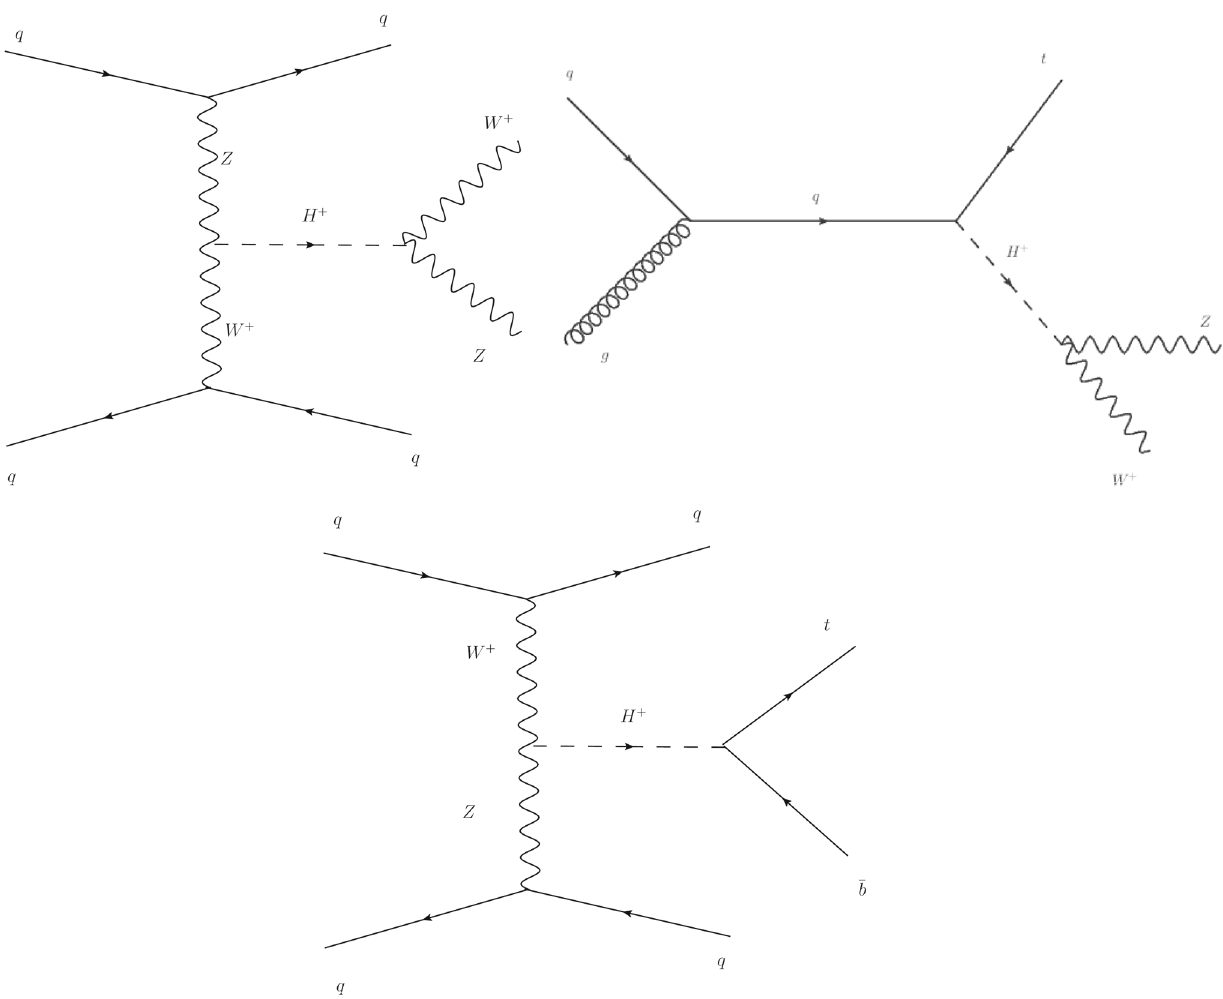
Fig. 14 | F Z , S | (left) and BR ( H + → W + Z ) (right) for M H + = 200 GeV and M S